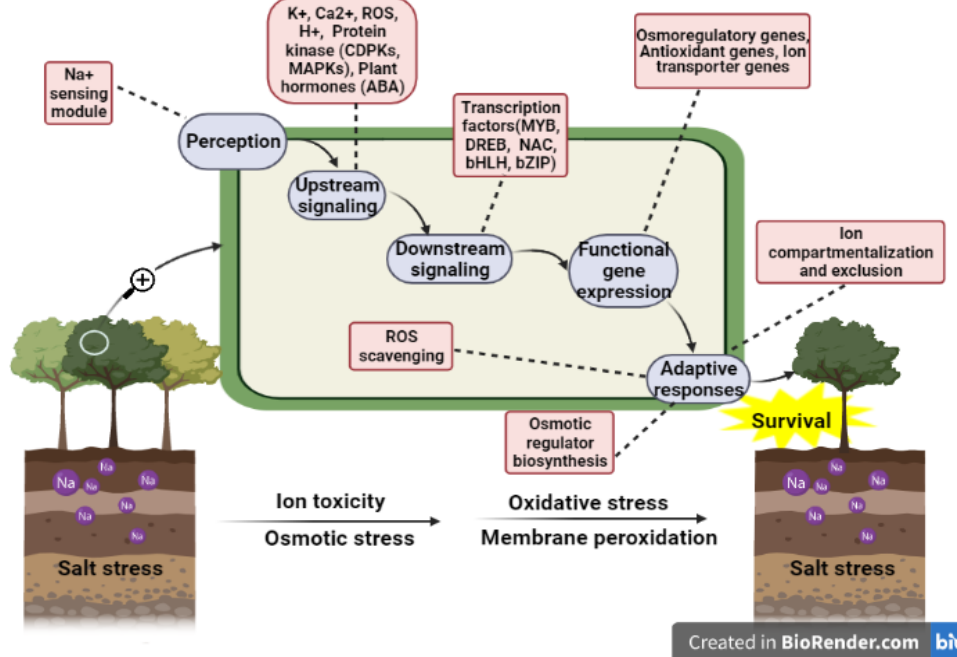
Figure 1. The process of plant salt tolerance development.